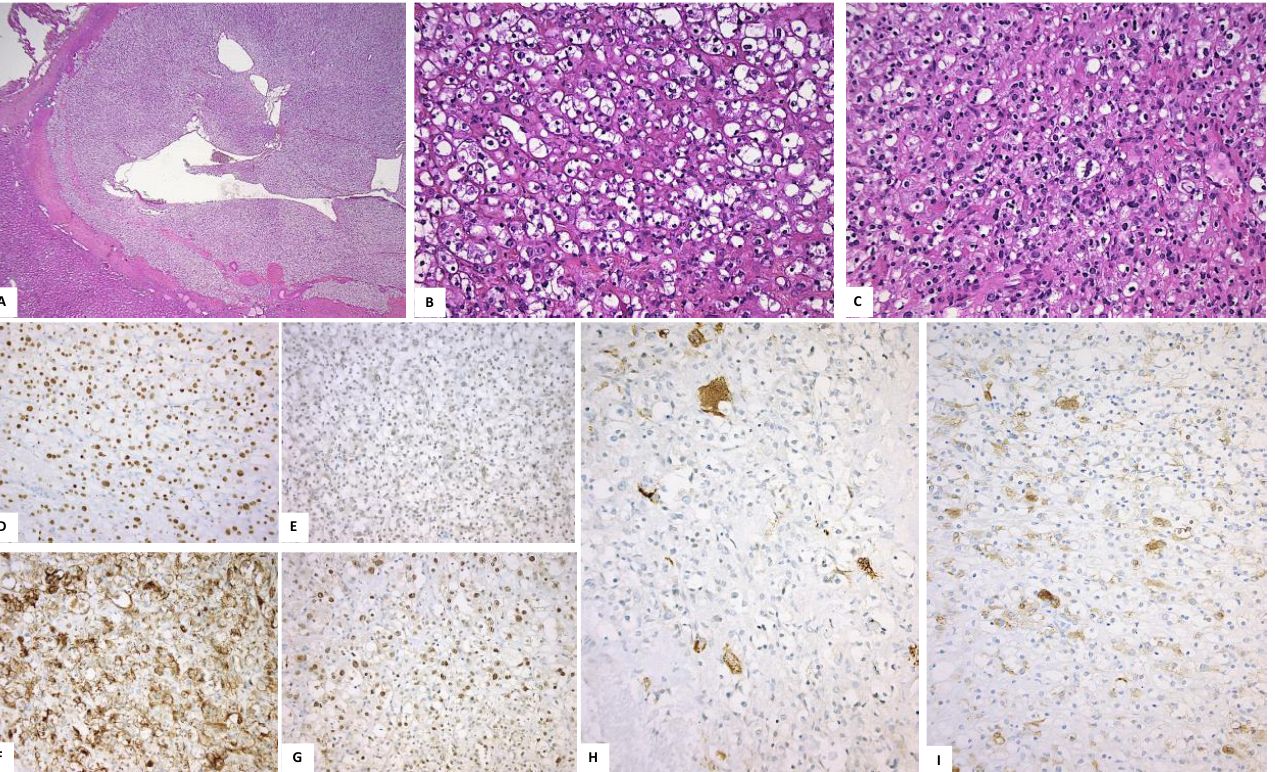
Figure 2. Morphological and immunohistochemical features of TFEB-tRCC mimicking clear cell RCC. ( A – C ): Morphology and features. ( A , B ): Massive architecture; ( B , C ): mixed eosinophilic and clarified cells (HES staining, magnification ( A ) × 12.5, ( B , C ) × 200); ( D – F ): immunohistochemical features. ( D ): PAX8 positivity; ( E ): CAIX negativity; ( F ): AE1–AE3 positivity for some cells; ( G ): TFE3 nuclei positivity for some cells; ( H ): HMB45 cytoplasmic positivity for few cells; ( I ): Melan-A cytoplasmic positivity for few cells ( D ): PAX8, ( E ): CAIX, ( F ): AE1-AE3, ( G ): TFE3, ( H ): HMB45, ( I ): Melan-A IHC, respectively, magnification ×200); tRCC: translocation renal cell carcinoma; HES: hematoxylin – eosin – safran.